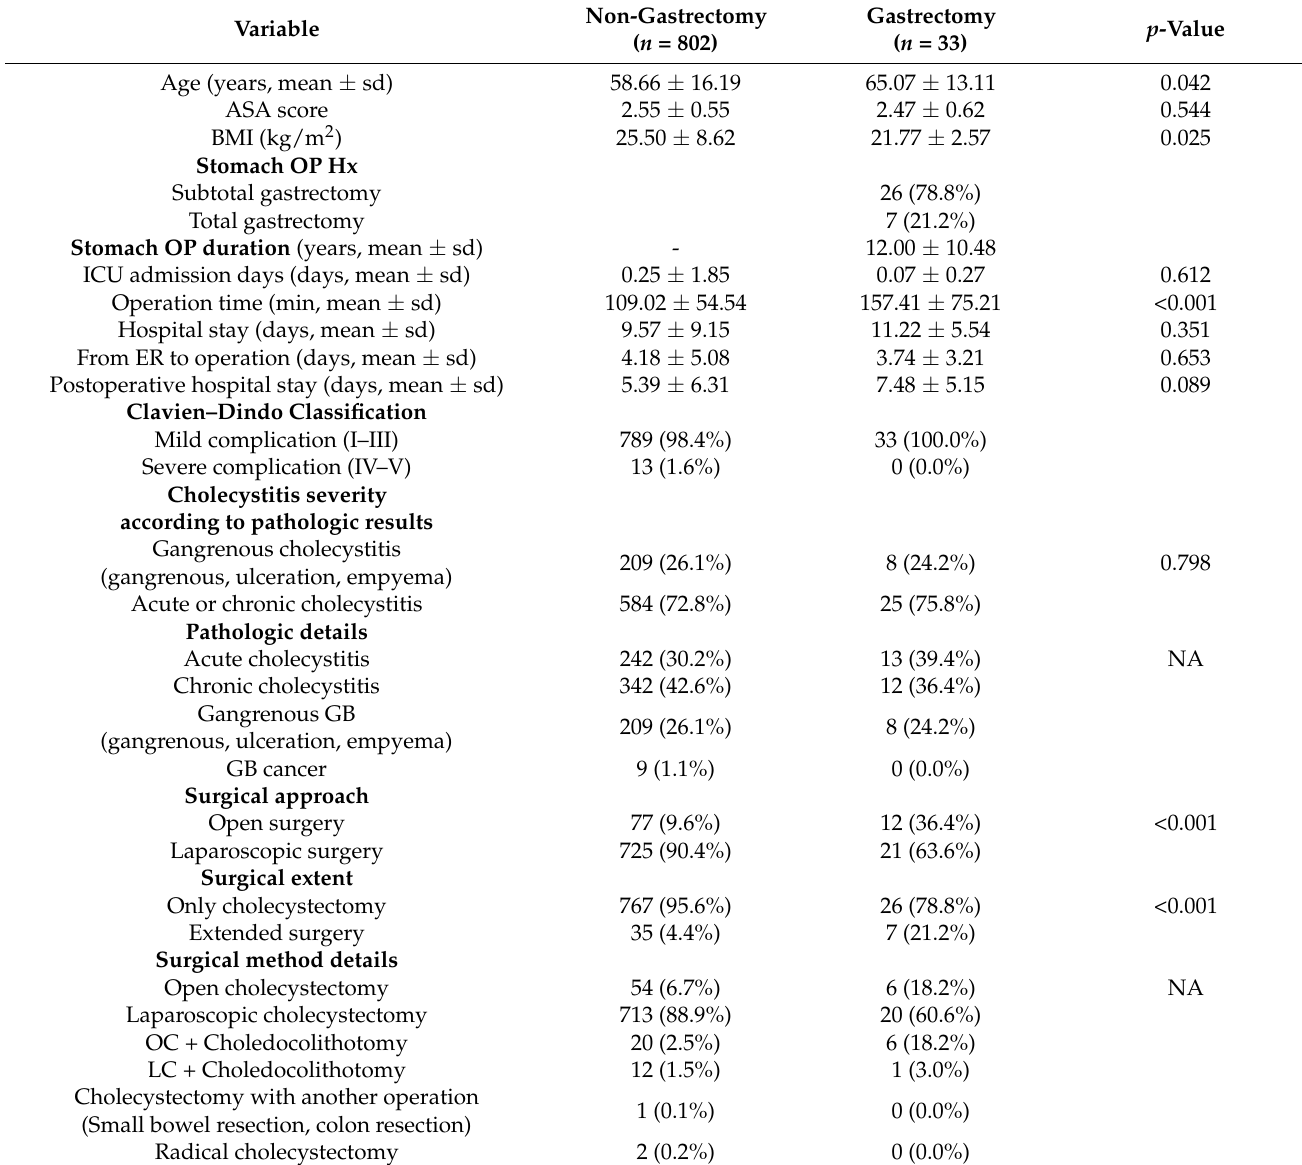
Table 4. Clinical and pathologic characteristics of male cholecystitis